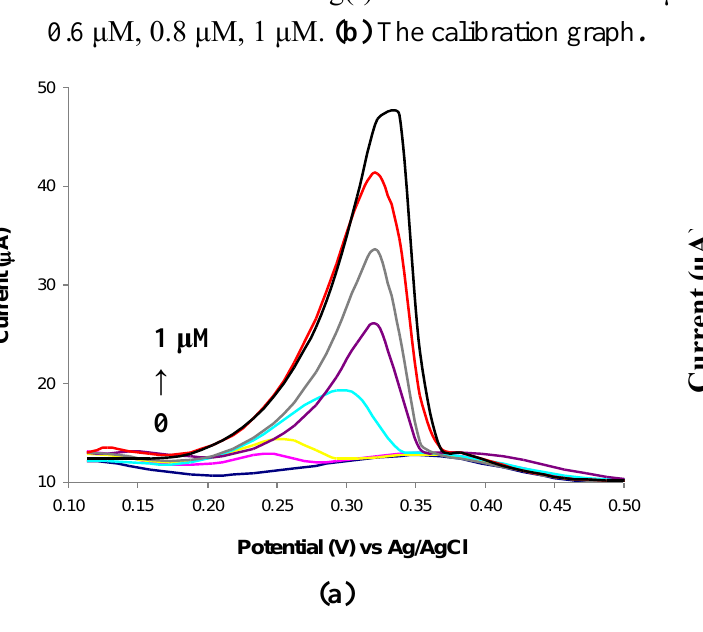
Figure 2. (a) Differential pulse voltammograms of Ag(I) accumulated on the ABP-modified GCE. Ag(I) concentrations were: 0 μM, 0.05 μM, 0.1 μM, 0.2 μM, 0.4